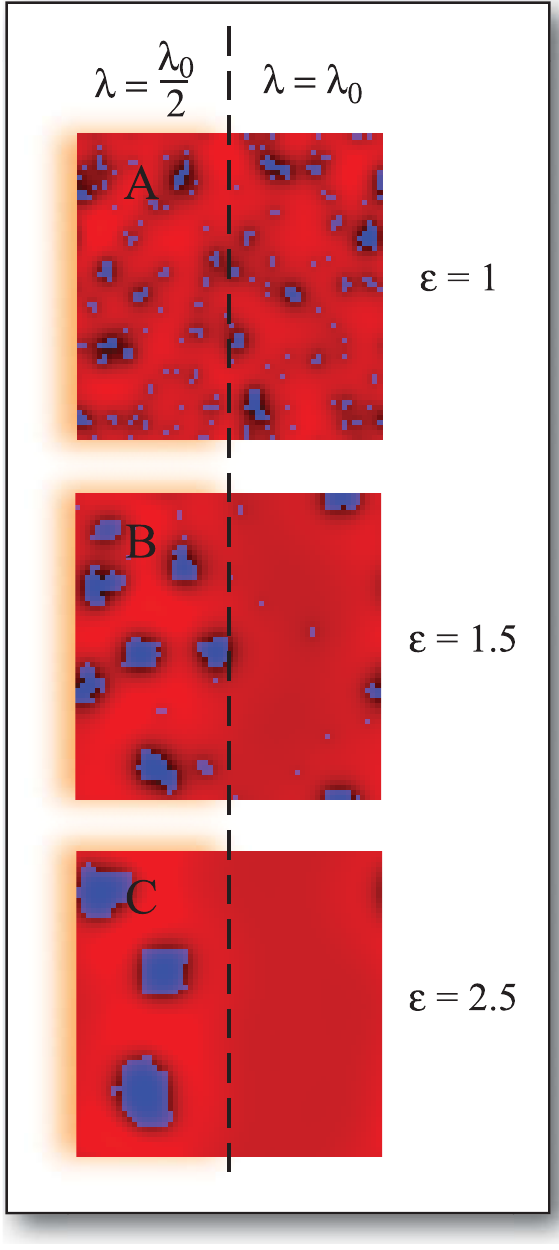
Figure 5. Localization of Lipid Clusters by Heterogeneous Membrane Pinning Membrane with uniform cell-wall curvature, fixed stiffness modulus j ¼ 25 k B T and lipid A intrinsic curvature c ¼ 0.4 nm (cid:1) 1 , and varying short-range attraction (A) e ¼ 1 k B T, (B) e ¼ 1.5 k B T, and (C) e ¼ 2.5 k B T . The pinning modulus of the left half of the membrane is lower by a factor of two ( k ¼ k 0 /2 ¼ 0.125 k B T /nm 4 ) relative to the right half of the cell ( k ¼ k 0 ). The color scheme and fraction of lipid A ( u ¼ 0.075) are the same as in Figure 2.